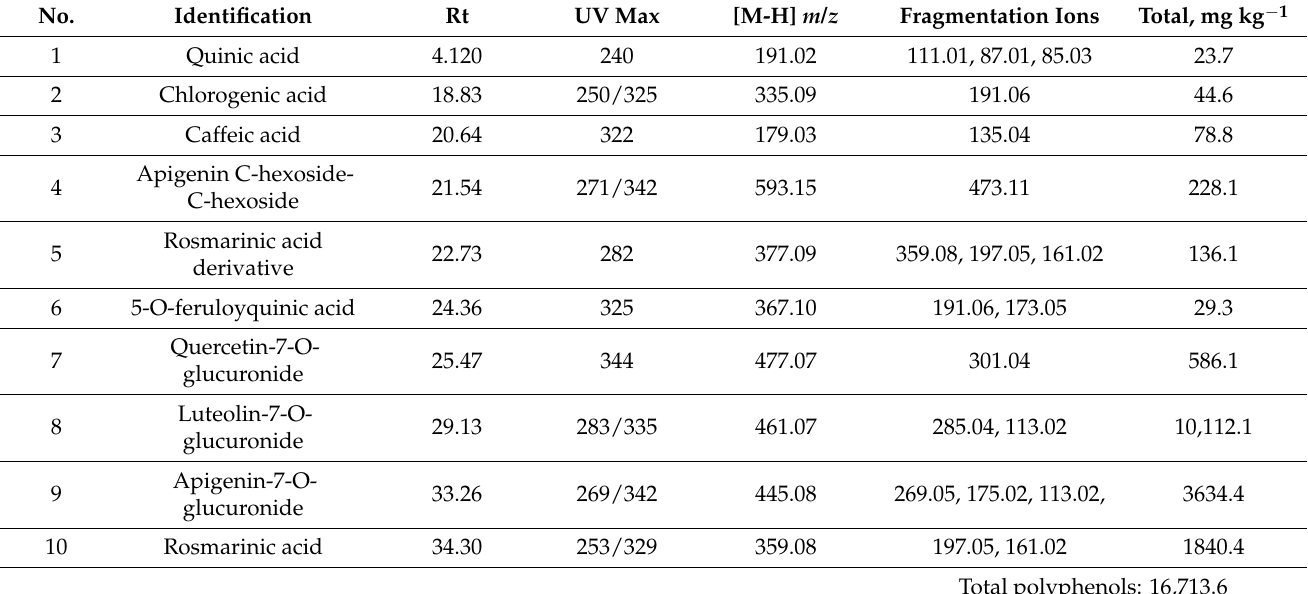
Table 3. Identification of the polyphenolic compounds in T. baicalensis .